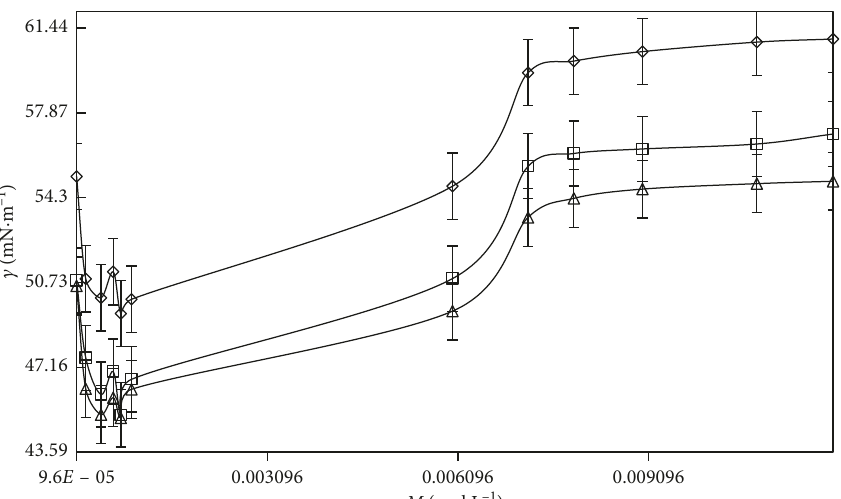
Figure 10: The c value of the SDS-rich surfactant at the three different temperatures T � 293.15 ( ◊ ), 298.15 ( □ ), and 303.15K ( △ ), respectively.